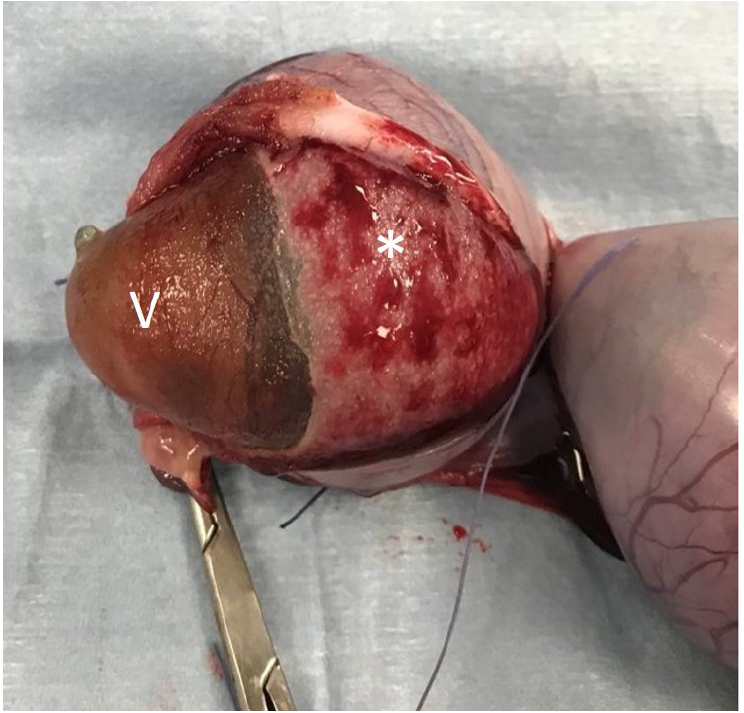
Figure 3. Dissection of an embryonic vesicle from the uterus. Embryonic vesicle is marked with “V” and the chorionic membrane with “*”.